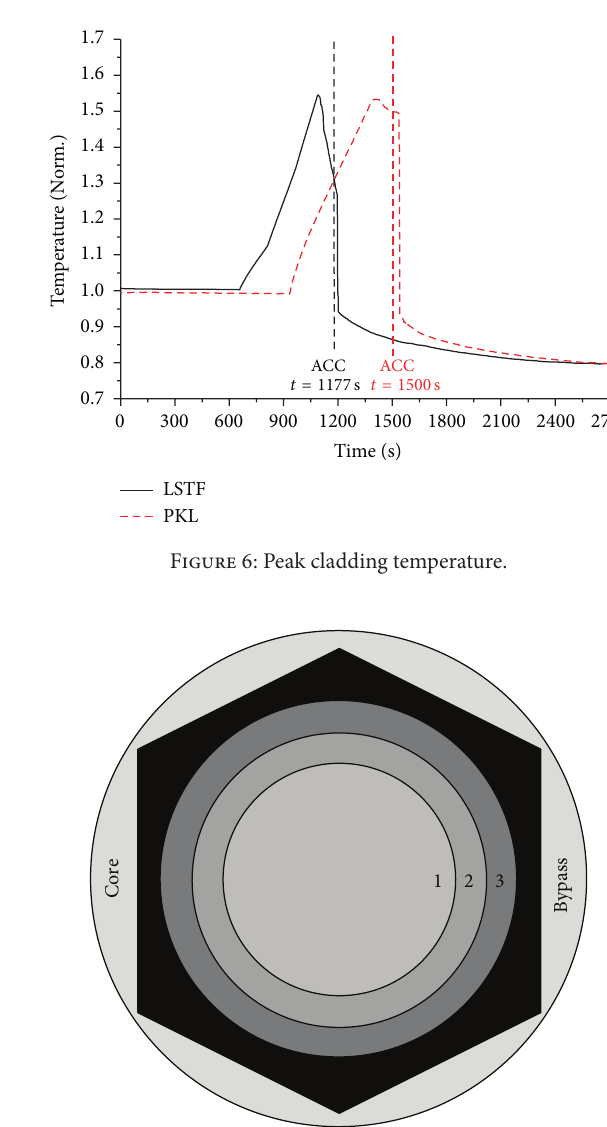
Figure 7: UPC PKL pseudo-3D nodalization core